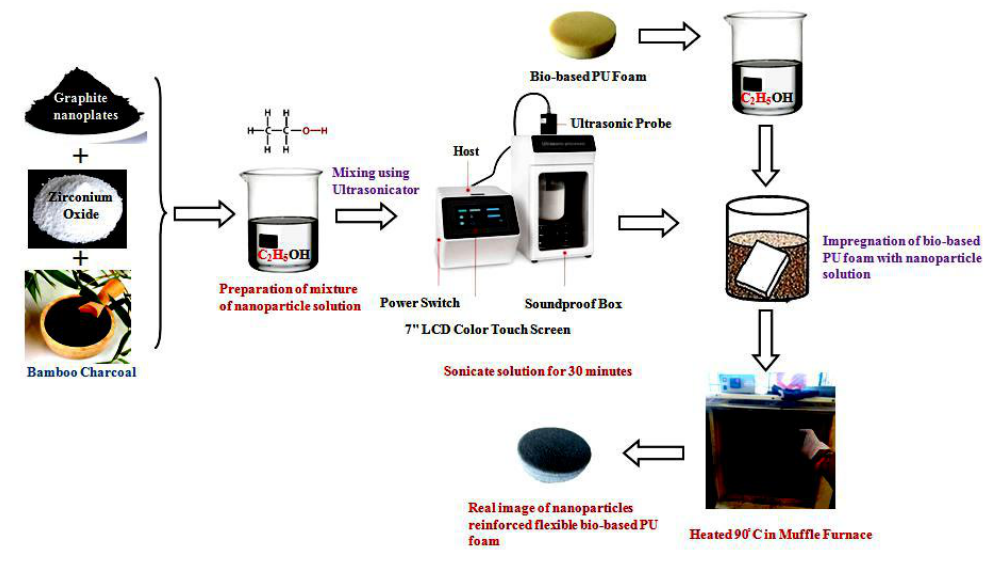
Figure 1. Experimental flow chart of nanoparticle reinforcement in flexible bio-based polyurethane foam.